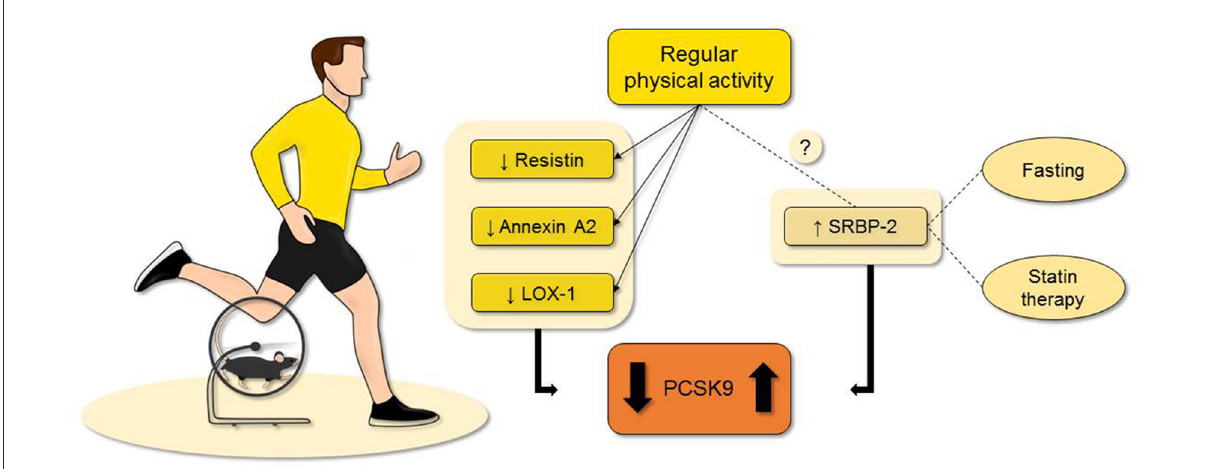
FIGURE1 Evidence suggest that regular physical activity can regulate the PCSK9 plasma levels even though few evidence is available at the moment. As possible explanations, the reduction of resistin, annexin A2, and LOX-1 are reported with the most concrete results. Although, PCSK9 can be also augmented in trained subjects. This is probably related to a higher metabolism, a possible undiscovered mechanism, or confounding factors. While it is less known if exercise training affects the plasma levels of SREBP2, both fasting and statin treatment represent two confounding factors when evaluating the possible role of physical activity on PCSK9 levels. LOX-1, lectin-type oxidized low-density lipoprotein receptor-1; Proprotein convertase subtilisin/kexin type 9; SREBP2, sterol regulatory element-binding protein